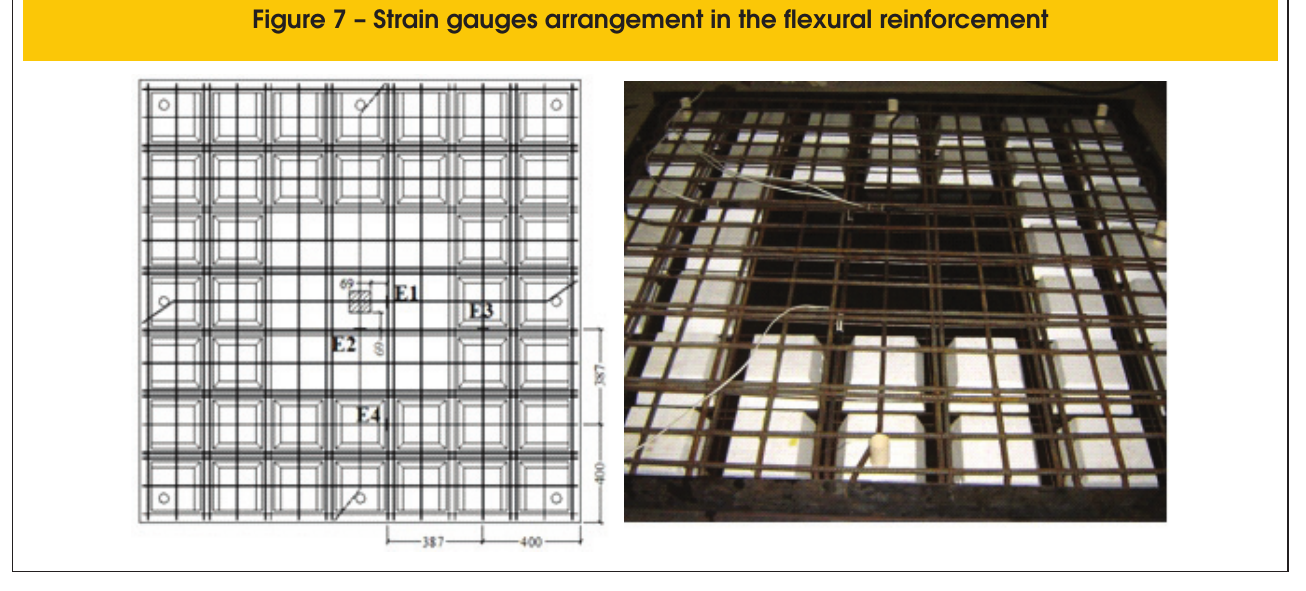
Figure 7 – Strain gauges arrangement in the flexural reinforcement